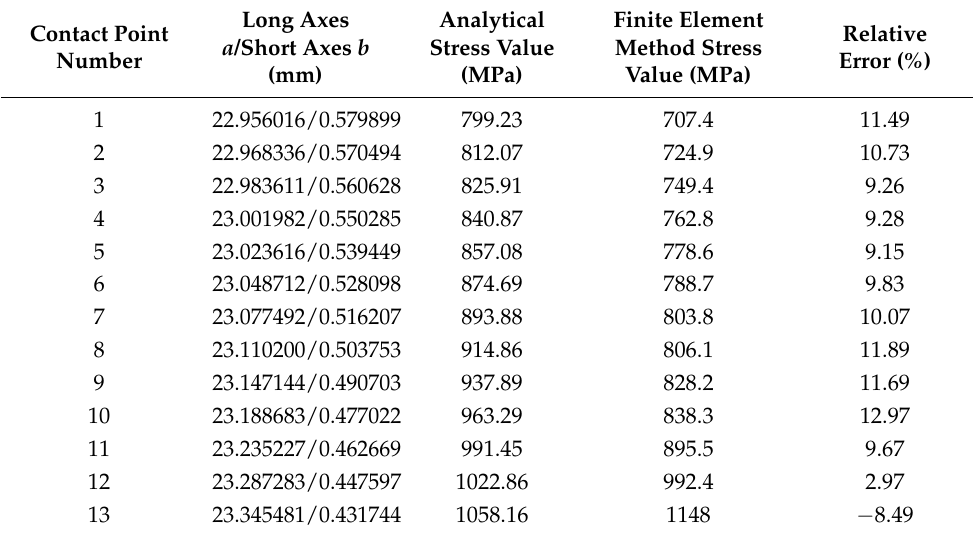
Figure 8. The contact area calculated by the ELTCA algorithm. Table 2. Contact stress comparison between the finite element simulation and the ELTCA.